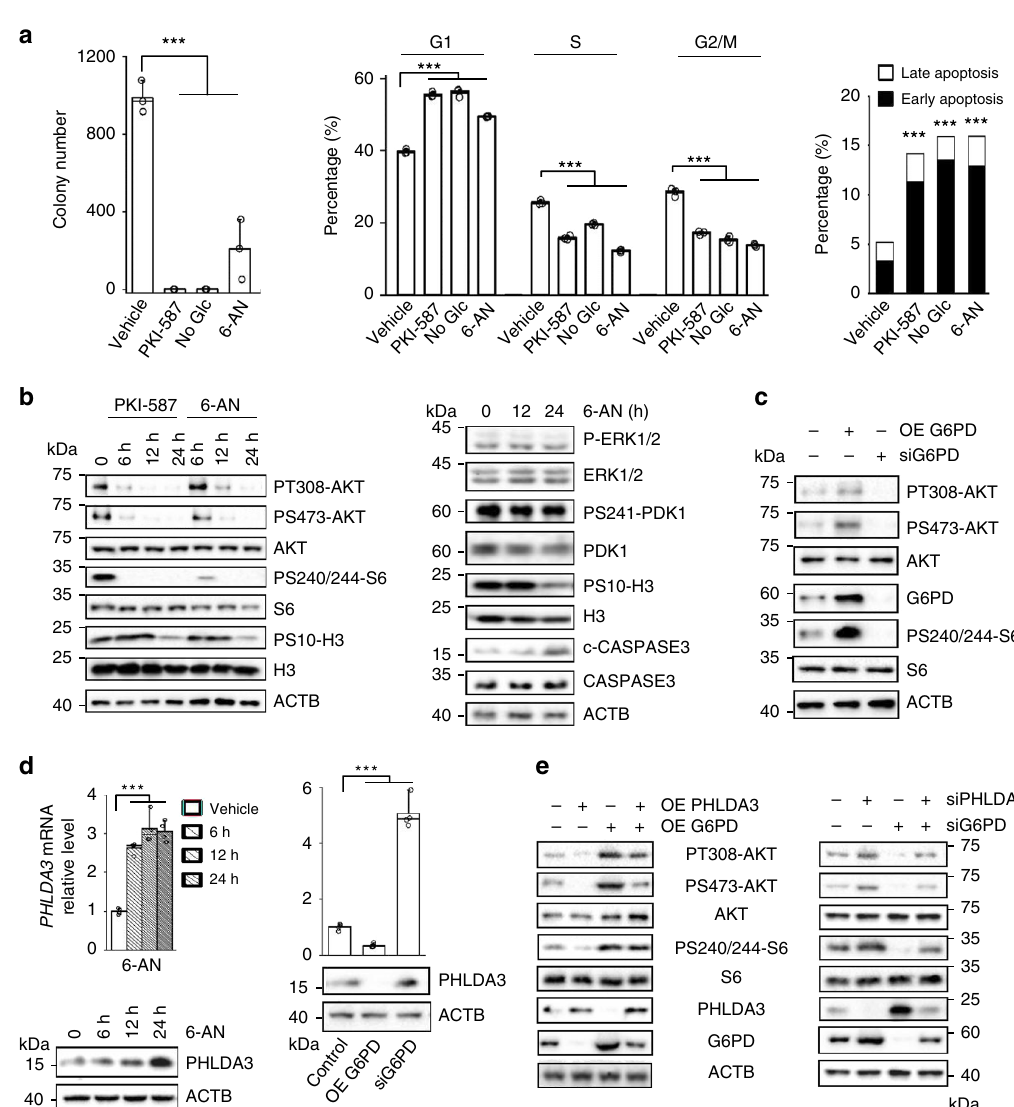
Fig. 5 PPP promotes cell growth and AKT activation by inhibiting PHLDA3. a 6-AN treatment inhibits cell growth, similar to glucose starvation and PKI- 587 treatment. Pten null mES cells were seeded in 3.5 cm dishes at a density of 2000 cells/well. Forty-eight hours later, the cells were treated with PKI-587 (1 µ M), 6-AN (100 nM) or glucose depletion. The colony numbers were counted 7 days later (left panel), while the percentages of cells in each phase of the cell cycle and apoptosis were measured by FACS analysis after 24 h of PKI-587 (1 µ M) or 6-AN (100 nM) treatment or 12 h in glucose-depleted medium (right panel, lower panel). b 6-AN treatment inhibits AKT activity, similar to the effect of PKI-587 treatment (left panel), but has no effect on the ERK and PDK1 activities (right panel). The Pten null mES cells were treated with PKI-587 (1 µ M) or 6-AN (100 nM) for the indicated time periods. Cell lysates were subjected to immunoblotting with the indicated antibodies. c Overexpression or knockdown of G6PD alters the AKT activities in PC3 cells. d The PHLDA3 mRNA and protein levels are regulated by 6-AN and G6PD activity in PC3 cells. e The PPP regulates AKT activity through a PHLDA3- dependent mechanism. PHLDA3 overexpression abolished the G6PD overexpression-induced AKT activation (left), while PHLDA3 knockdown blocked the G6PD knockdown-induced AKT inactivation in PC3 cells (right). Data are presented as the mean ± SD and were compared with untreated cells. Each experiment was performed n = 3 ( a ) and n = 4 ( d ) independent times. * p < 0.05, ** p < 0.001, and *** p < 0.001, based on Student ’ s t test (two-sided ANOVA). See also Supplementary Fig. 5. Source data are provided as a Source Data fi kinetics of response to 6-AN treatment and R5P or uridine supplementation compared with the endogenous gene (Fig. 6f, lower left panel; Supplementary Fig. 6G). G6P showed similar inhibition, while pyruvate and lactate had no obvious effects on the PHLDA3 promoter activity (Fig. 6f, lower right panel). Importantly, PHLDA3 driven by an exogenous promoter did not respond to 6-AN treatment or R5P and uridine supplementation (Fig. 6g). Truncation analysis further identi fi ed the minimal region for PPP inhibition as − 829 to + 431 (Fig. 6h). PHLDA3 expression is